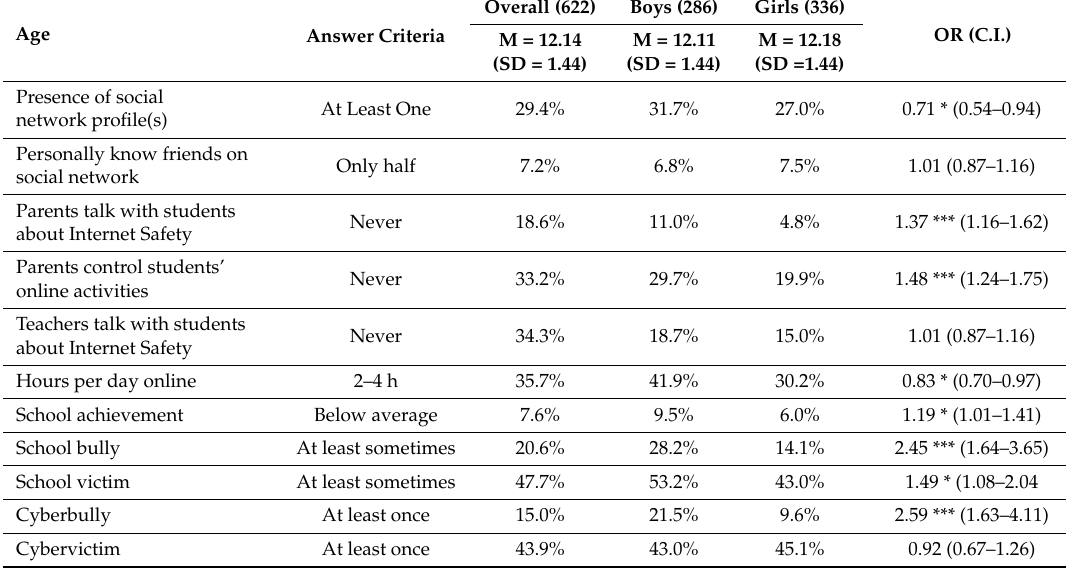
Table 1. Descriptive statistics for the